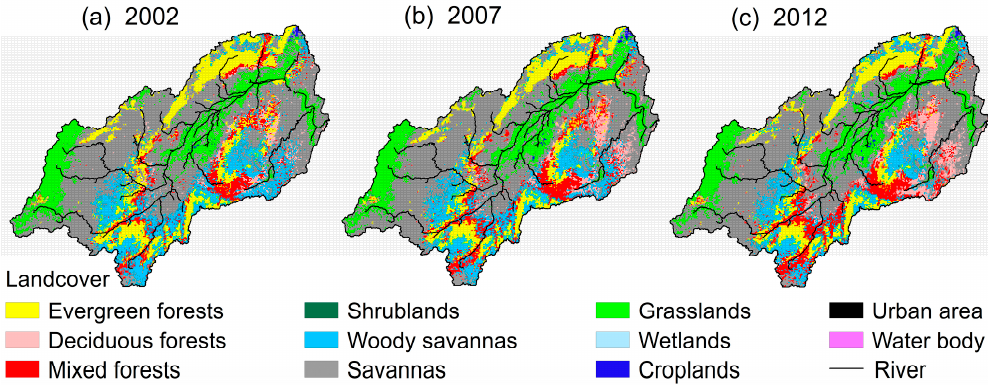
Figure 2. Moderate Resolution Imaging Spectroradiometer (MODIS) imagery program land cover classes in the Kilombero River catchment for the years 2002 ( a ), 2007 ( b ), and 2012 ( c ) [38]. Table 1. Moderate Resolution Imaging Spectroradiometer (MODIS) imagery program land covers in the Kilombero River catchment for the years 2002, 2007, and 2012 [38]. Land Cover (%)